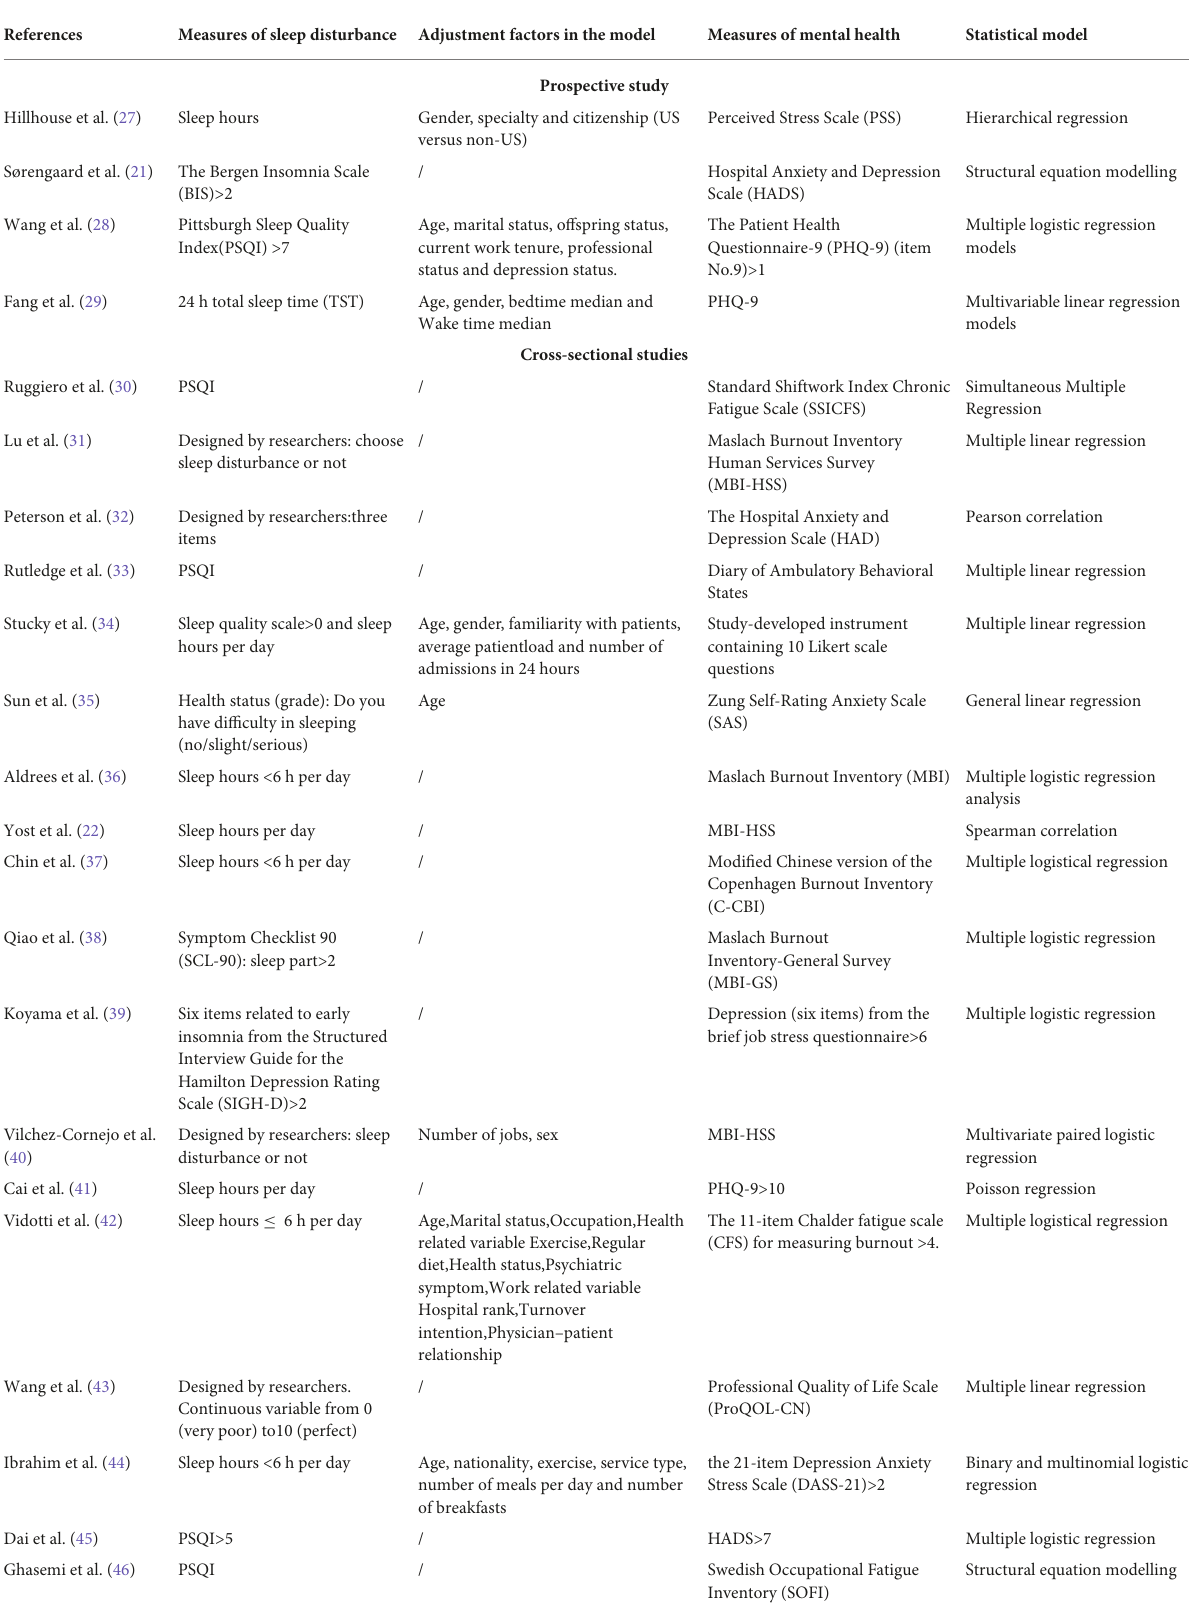
TABLE 2 Measures of sleep disturbance and mental health in the included studies ( n =